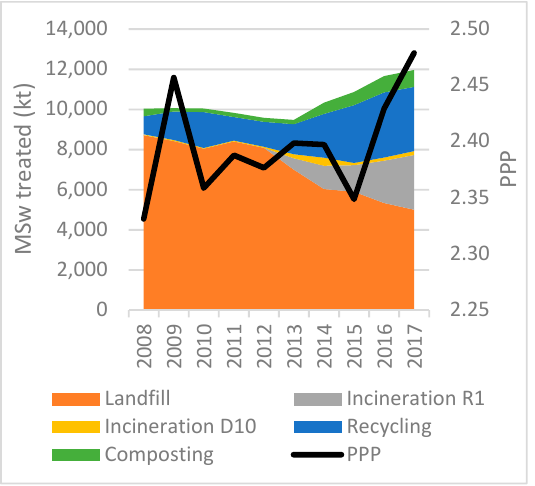
Figure 41. Population and MSW production in Poland 2008–2017 (EUROSTAT 2019a, 2019c). Soc. Sci. 2019 , 8 , x FOR PEER REVIEW